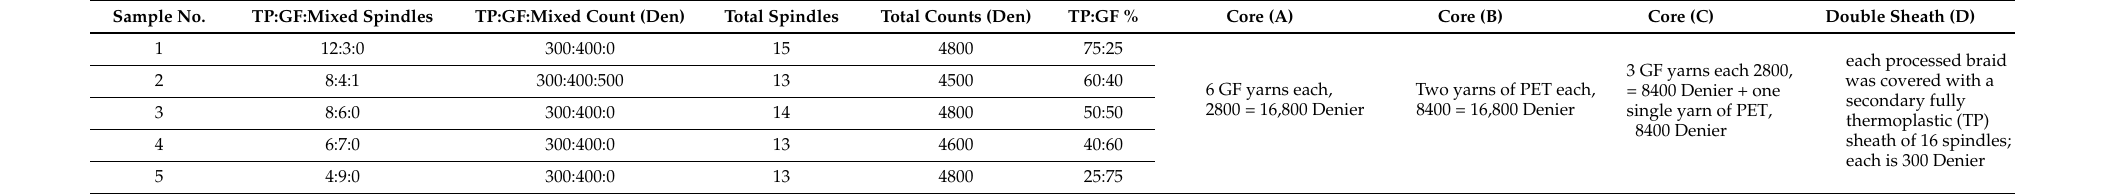
Table 5. Different setups for the braiding structure using the E-glass fiber.